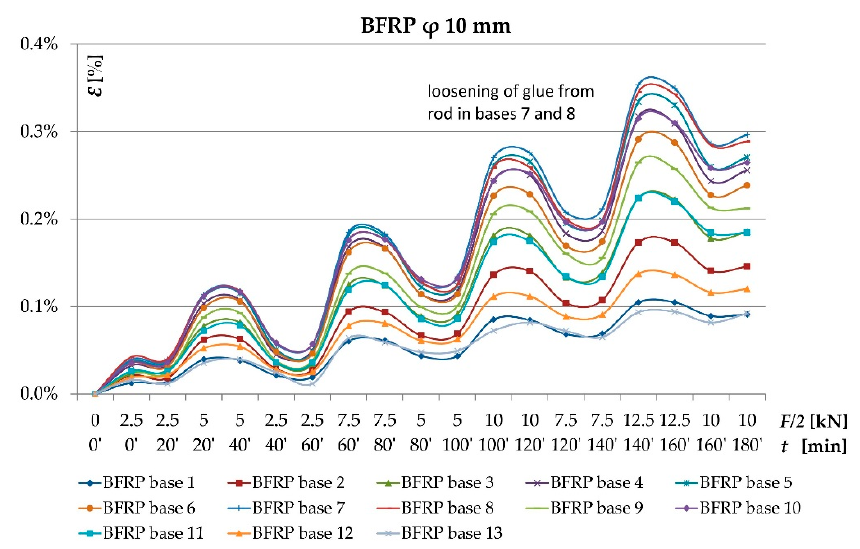
Figure 7. Chart of the BFRP rod’s Ɛ [%] and F/2 [kN] – including time during loading dependency for the Wa-A1 reinforced beam.